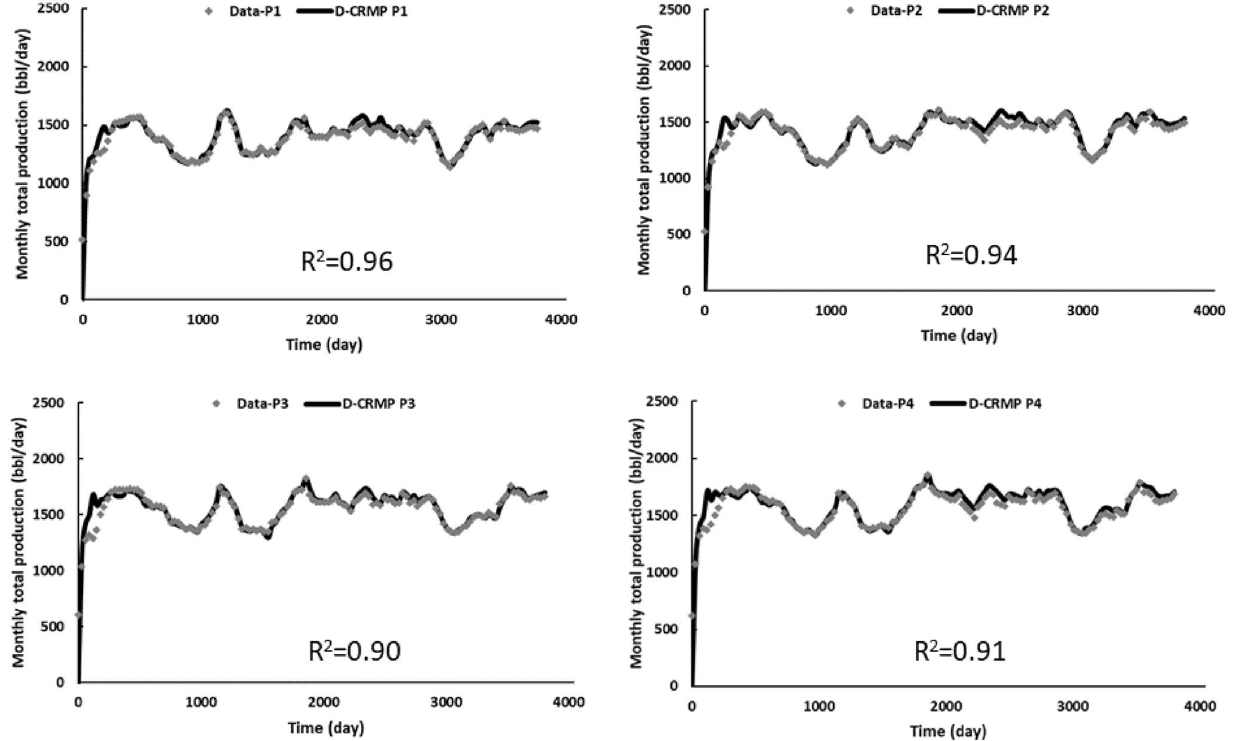
Fig. 15 Liquid production rates match by D-CRMP in case